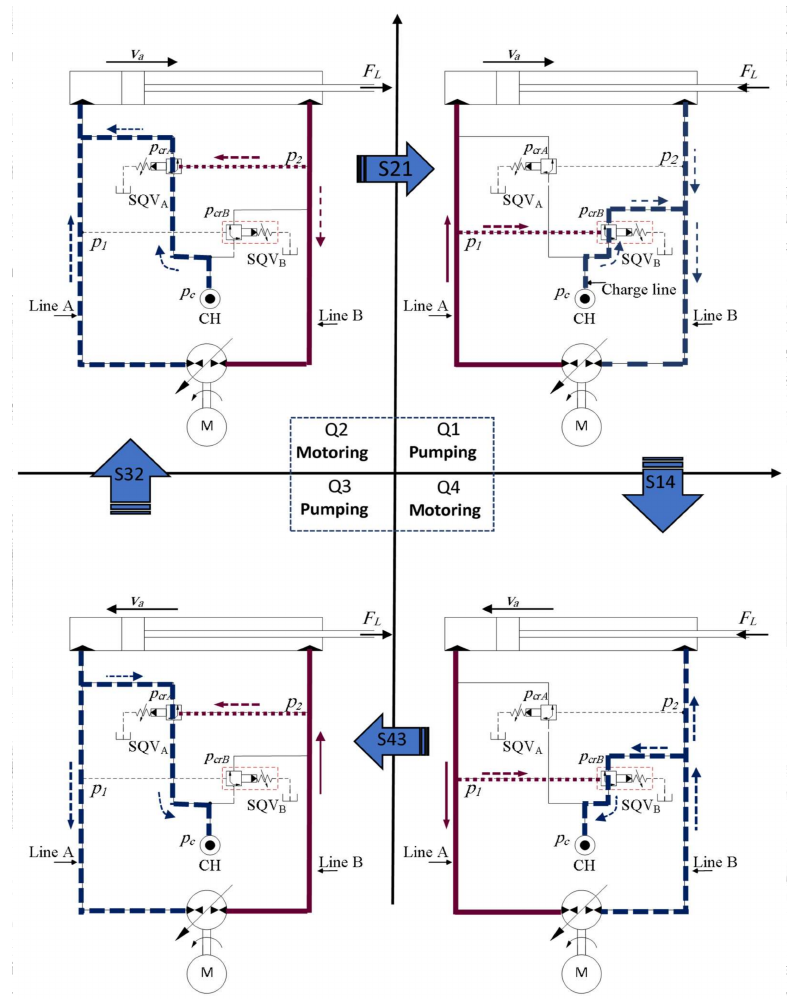
Figure 15. Flow patterns in four quadrants of operation and switching zones of the circuit shown in Figure 9, in the F L − v a